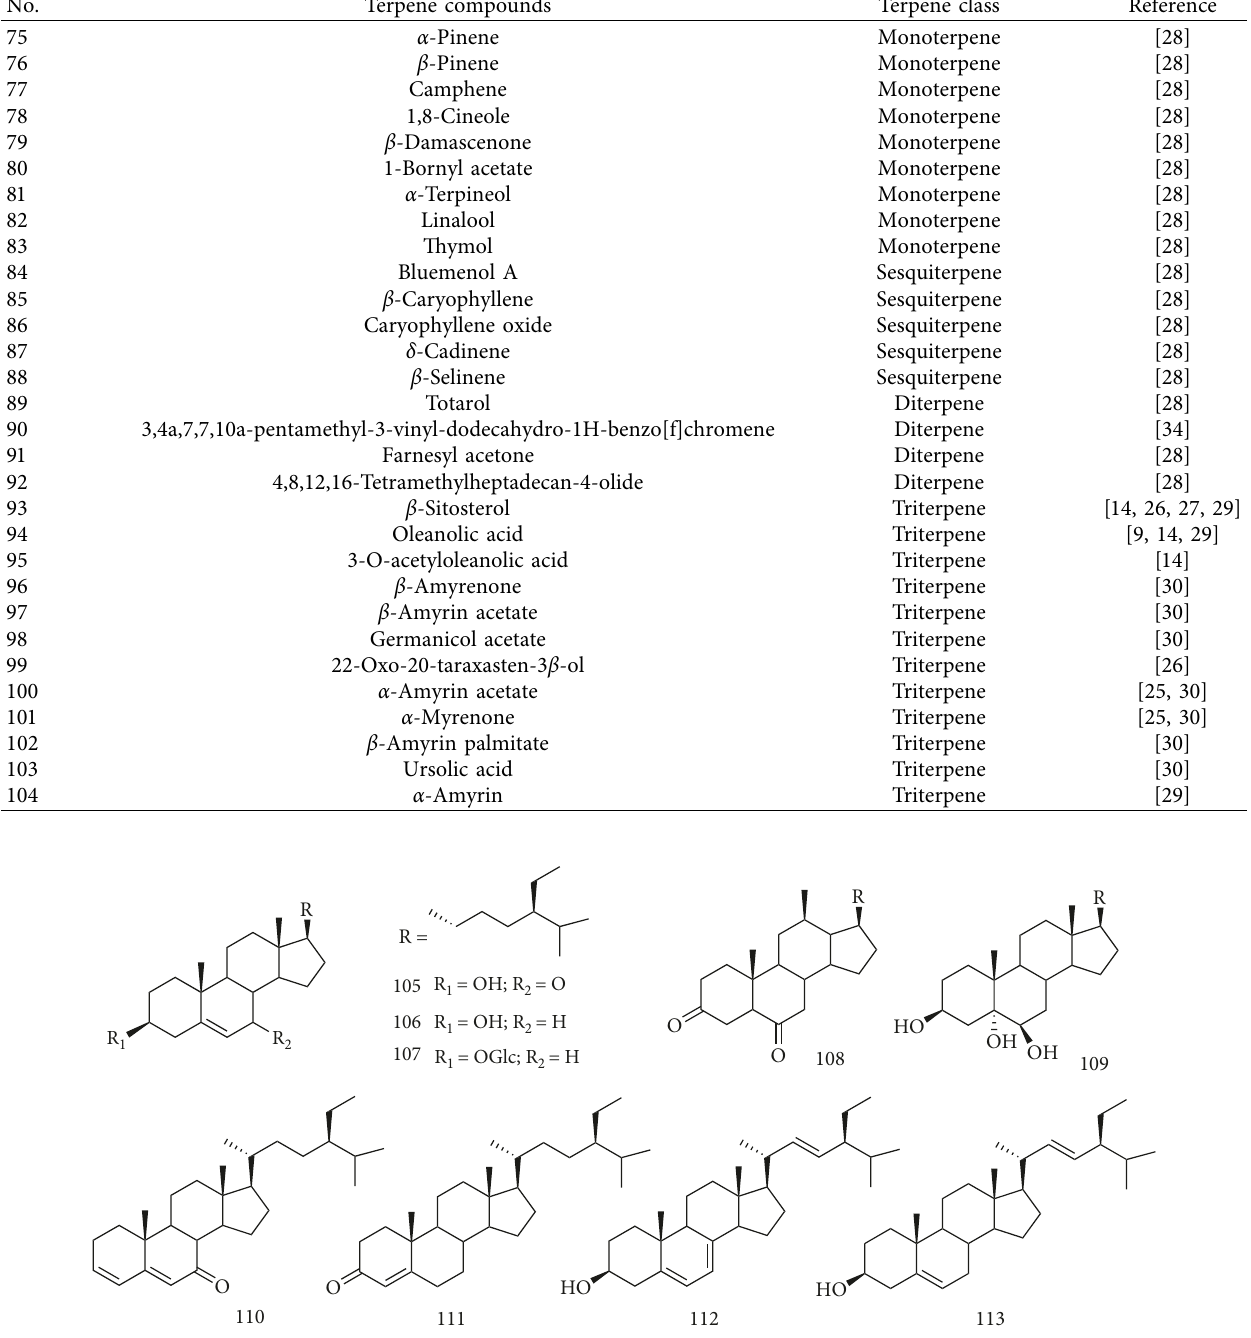
Figure 4: Structures of the steroids found in F. tikoua